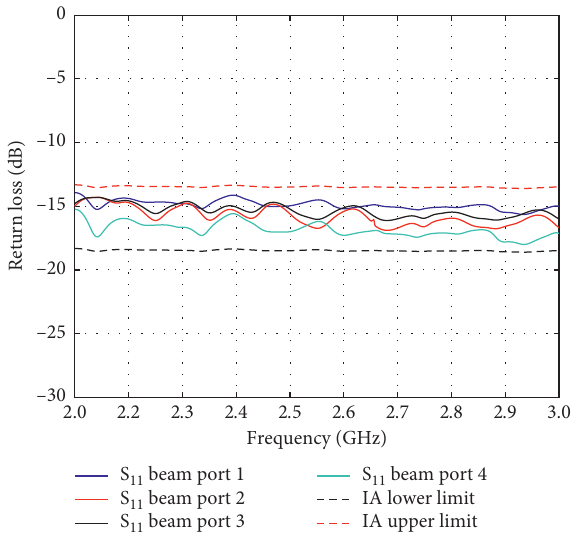
Figure 5: S-band Rotman lens: return loss at the beam ports.